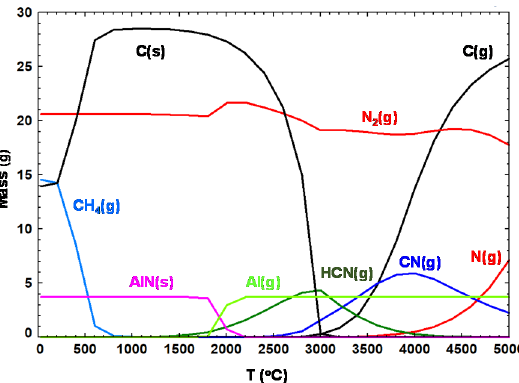
Figure 2. Thermodynamics plots showing the potential of producing AlN from melamine through plasma